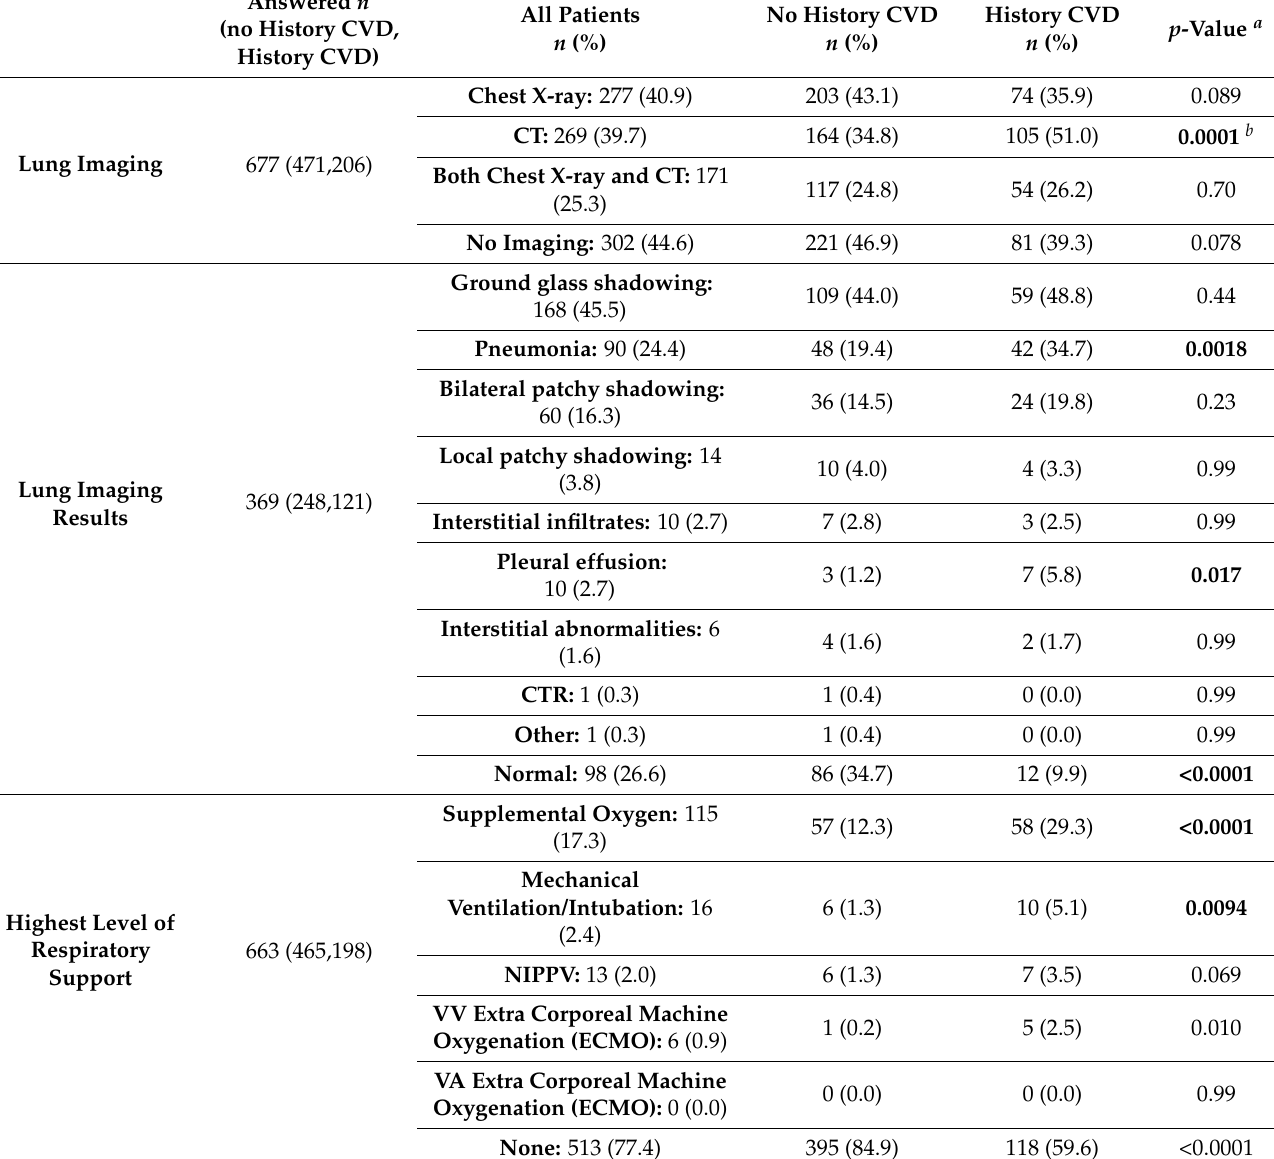
Table 4. Lung imaging and respiratory support for registry patients with or without a history of